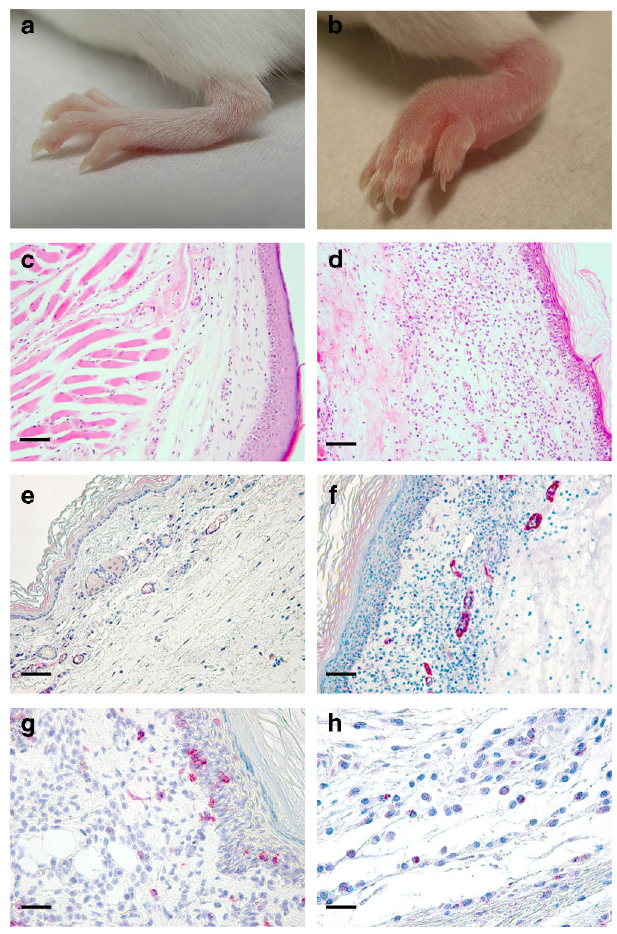
Fig. 3 In fl ammatory response in the footpad of ECTV Δ CrmD-infected mice. Left hind foot ( a, b ), H&E staining ( c, d ) and anti-ICAM-1 staining ( e, f ) of zinc- fi xed footpad sections of representative BALB/c mice infected with 1000 PFU of ECTV ( a, c, e ) or ECTV Δ CrmD ( b, d, f ) at 7 dpi. Anti-CD4 staining ( g ) of zinc- fi xed and anti-CCR10 staining ( h ) of formalin- fi xed footpad sections of representative ECTV Δ CrmD-infected mice are shown. No cell in fi ltrate was observed in the ECTV-infected tissues. For all immunohistochemistry analyses, positively labelled cells appear in red color. Scale bar, 100 µ m ( c – f ) and 25 µ m ( g, h